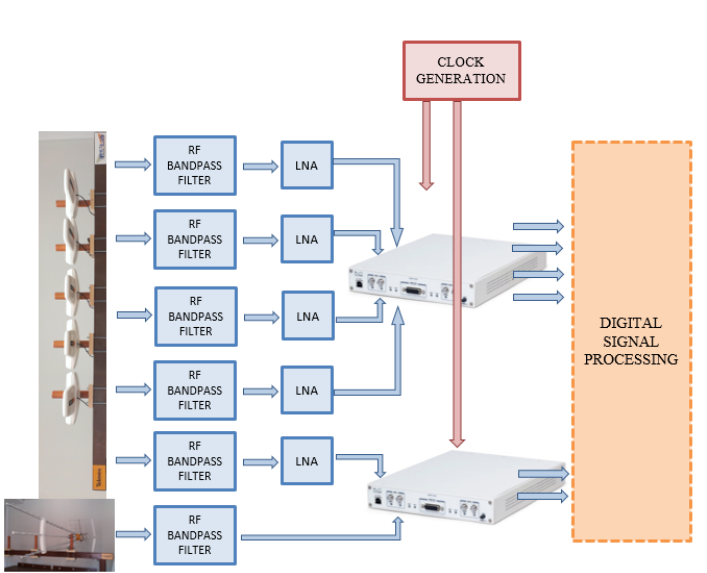
Figure 4. Functional block diagram of Improved Detection Techniques for Passive Radars